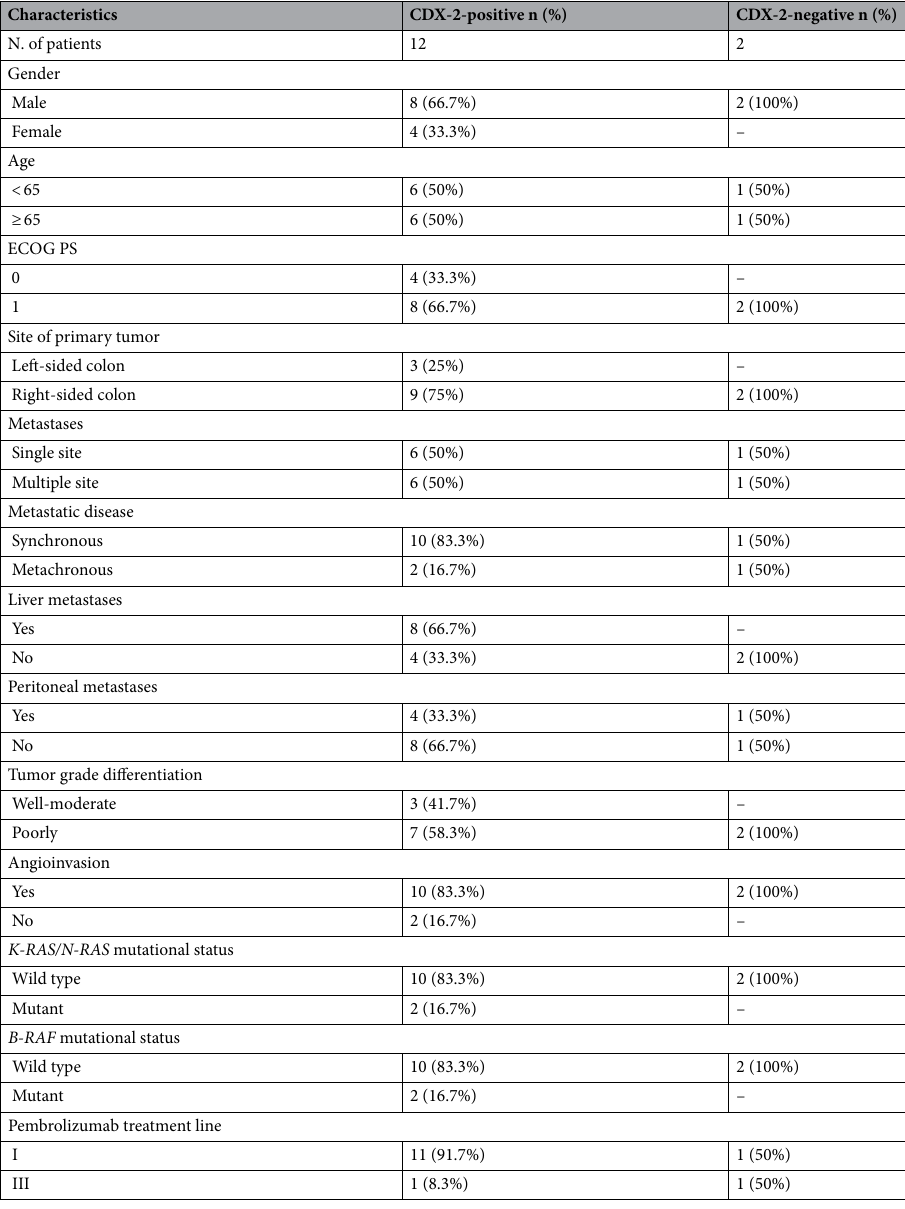
Table 1. Patients’ characteristics. ECOG PS: Eastern Cooperative Oncology Group Performance Status; K-RAS: Kirsten rat sarcoma virus; N-RAS: neuroblastoma ras viral oncogene homolog; B-RAF: v-Raf murine sarcoma viral oncogene homolog